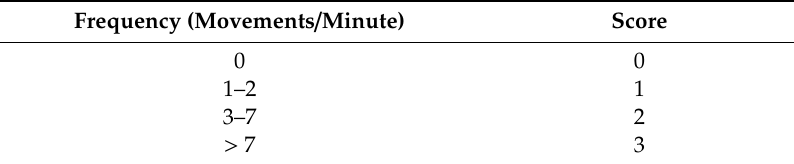
Table 2. Score assigned to the workstations depending on the frequency of movements that must be